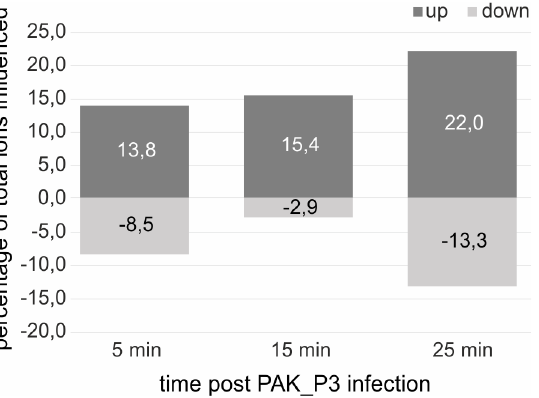
Fig 4. PAK_P3 alters P . aeruginosa metabolite content over the course of infection. Percentage of altered Pseudomonas metabolite ions during the course of infection (p-value (cid:3) 0,05, │ Log 2 (fold change) │ (cid:1) 0,5), y-axis shows percentage and x-axis shows the time points during infection. In total 377 ions were